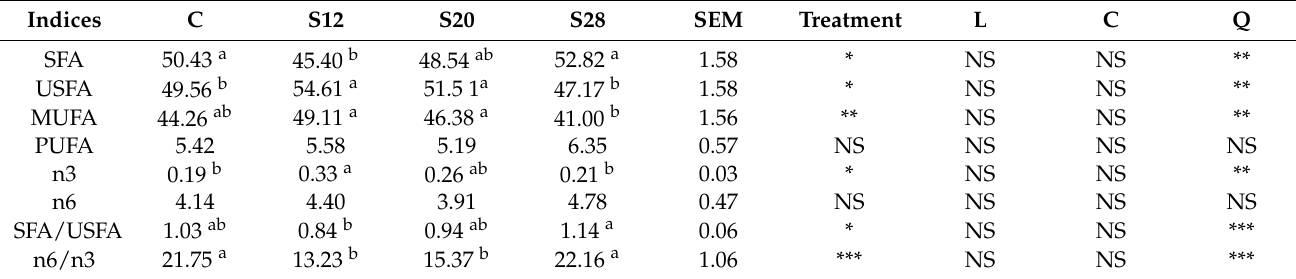
Figure 4. The effect of the differences in time of sampling on the colostrum composition. Table 6. Effect of sunflower hulls on colostrum fatty acid classes and indices